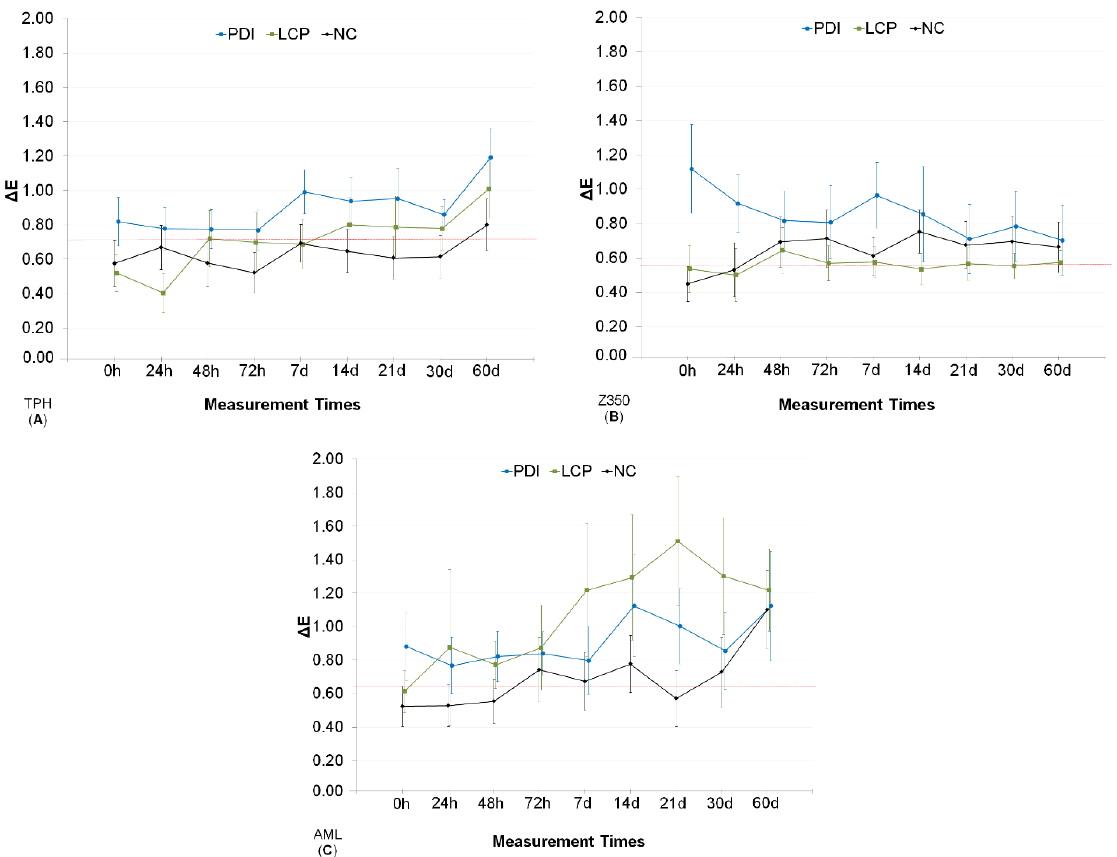
Figure 3. Mean and confidence intervals (CI 95%) for color changes ( ∆ E) obtained following treatment (PDI: curcumin-mediated photodynamic inactivation in a liquid crystal precursor system; LCP: only the liquid crystal precursor system without curcumin; NC: negative control with no treatment; only artificial saliva) at the different measurement times (0 h to 60 days). Type of composite resin: ( A ) is for TPH; ( B ) is for Z350; and ( C ) is for AML for comparison, the dotted red line indicates the upper limit of CI 95% from NC group at 0 h. Table 2. Mean values ( ± standard deviation) for the changes in color ( ∆ E) obtained after treatment (PDI: photodynamic therapy; LCP: Liquid crystal precursor without curcumin; NC: negative con- trol/artificial saliva) and the type of composite resin (TPH, Z350, AML). ‘Immediate’ indicates evaluations performed immediately after treatments, and ‘60 days’ indicates evaluations performed after 60 days of treatment (stored in artificial saliva).